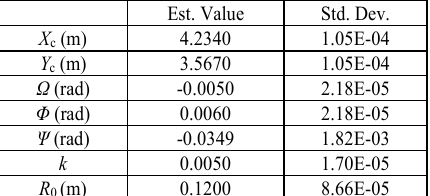
Table 3. Estimates of octagonal cone model fitting with the simulated data